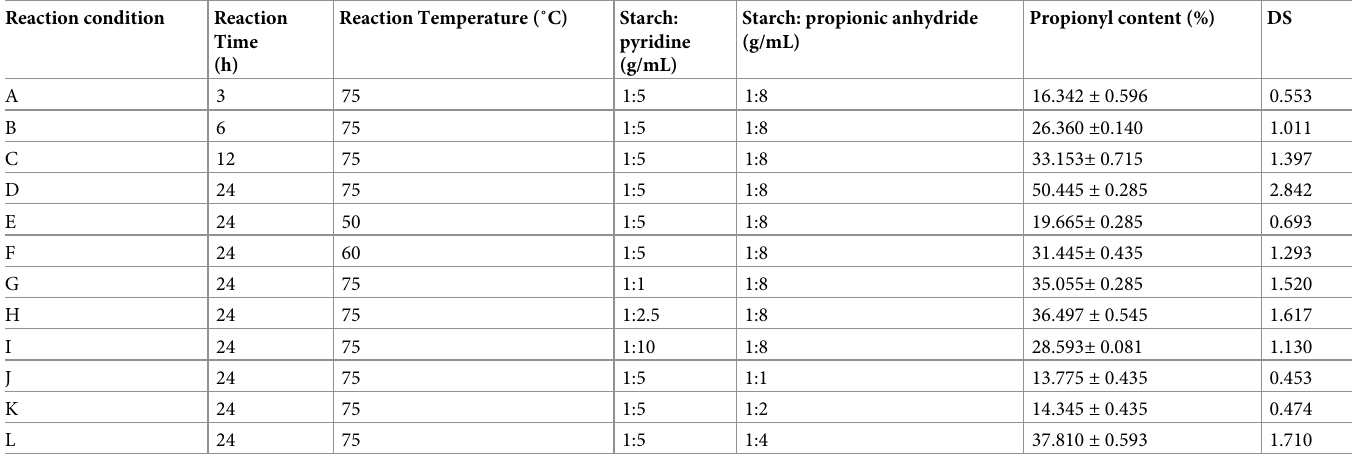
Table 2. Effect of reaction time, temperature, starch to pyridine ratio, and starch to propionic anhydride on propionyl content and DS of PDAS (n = 3, mean ± SD). Reaction condition Reaction